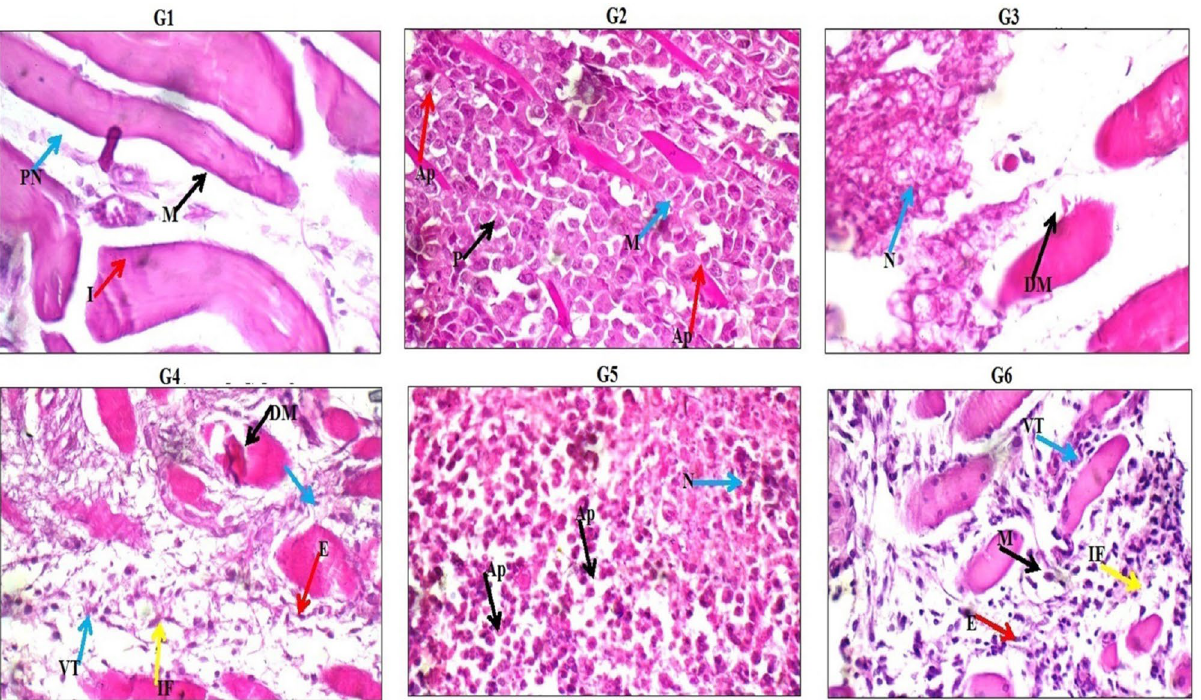
Figure 10. Histological examination of the tumor and muscle tissues of the negative control (G1), tumor control (G2), Doxorubicin treated (G3) and PSO treated (G4–G6) groups. DM: destructed muscle fibers; E: edema; VT: viable tumor cells; IF: inflammatory infiltrate; Ap: apoptotic cells; N; necrotic cells; M: skeletal muscle fibers; P: pleomorphic cells; PN: peripheral nuclei; I: interstitium.